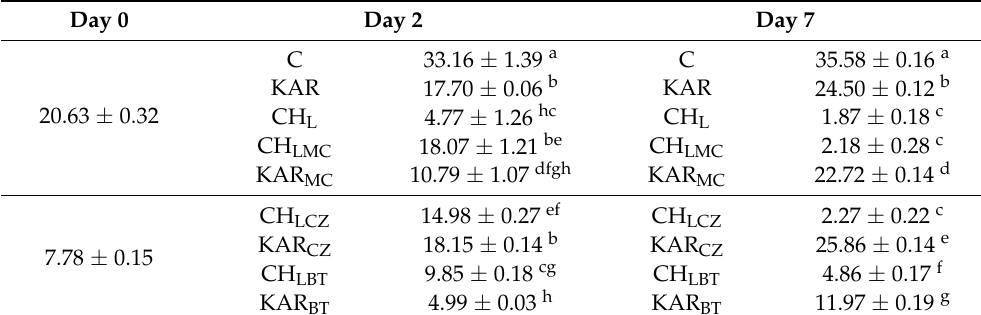
Table 5. DPPH scavenging activity (%) results of Golden Delicious apples packaged in prepared film-forming